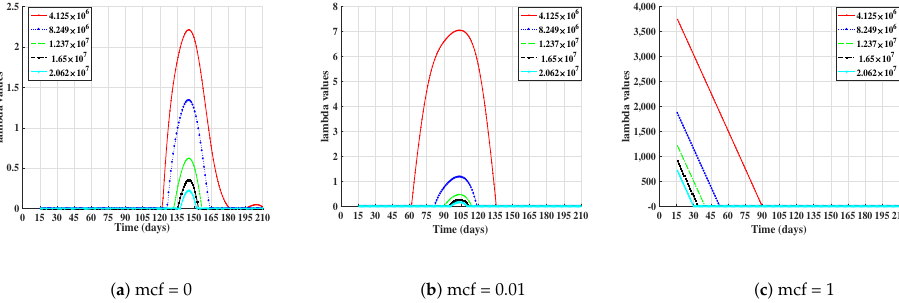
Figure 6. Example of dual variables from linear programming for fresh sugarcane in North-east region in 2017/18. Compare Hamiltonian derivative plots in Figure 5.